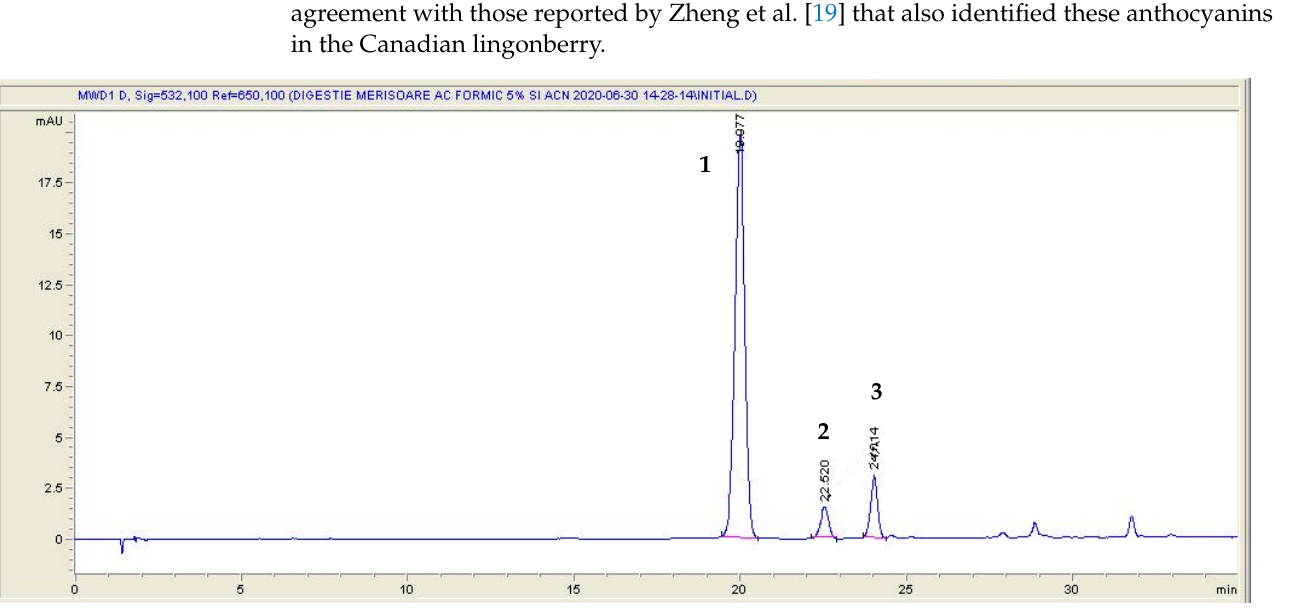
Figure 3. HPLC profile (532 nm) of anthocyanins: ( 1 ) cyanidin 3-galactoside; ( 2 ) cyanidin 3-glucoside; ( 3 ) cyanidin 3-arabinoside.